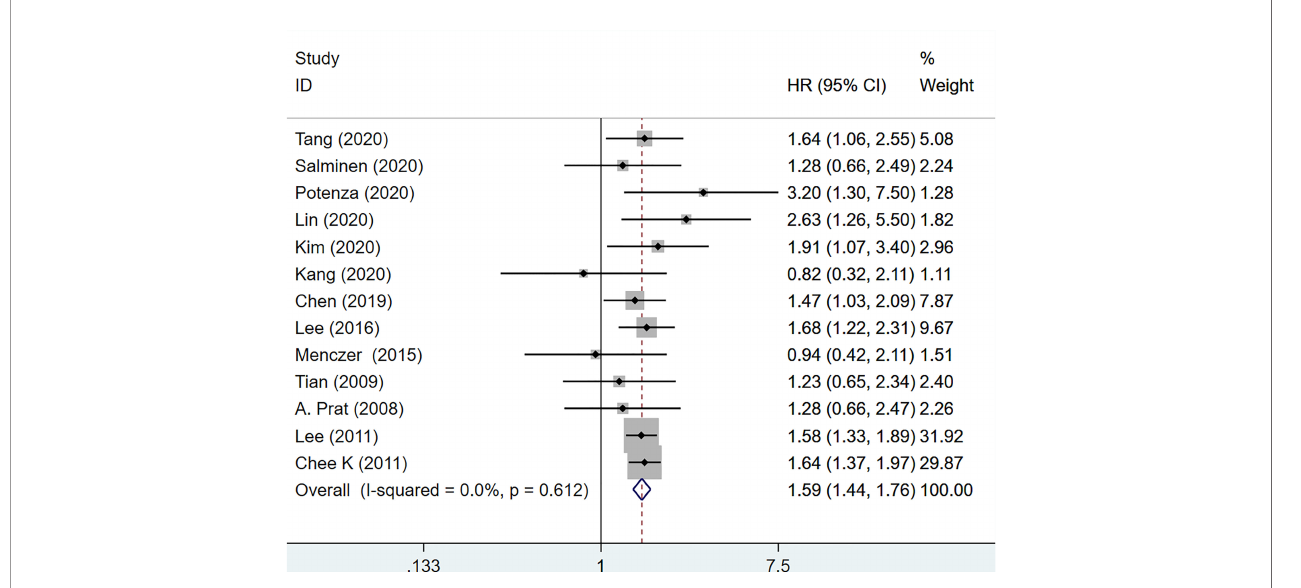
FIGURE 4 | Forest plot of the association of CA-125 level with PFS in EOC patients. CI, con fi dence interval; HR, hazard